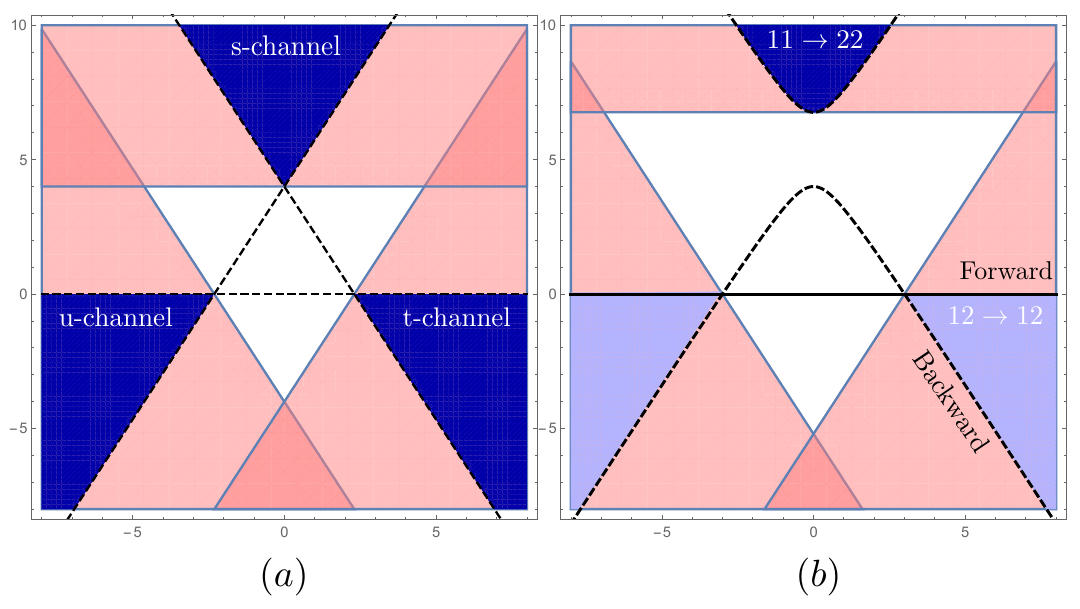
Figure 15. (a) Physical regions (in dark blue) for a two-to-two process with all external particles of identical mass. The boundary of these regions correspond to scattering angle 0 or (cid:25) and can thus also be identi(cid:12)ed with the physical scattering ‘regions" (or better scattering lines) in two dimensions. (b) Physical regions for a process where the masses are equal in pairs. The darker blue region is the process m 1 m 1 m 2 m 2 while the two lighter regions (which are equivalent for ! identical particles) correspond to the m 1 m 2 m 1 m 2 channels. The boundary of these regions ! are again the two dimensional physical lines. The boundaries of the lighter blue regions are not identical: one corresponds to forward scattering; the other to backward